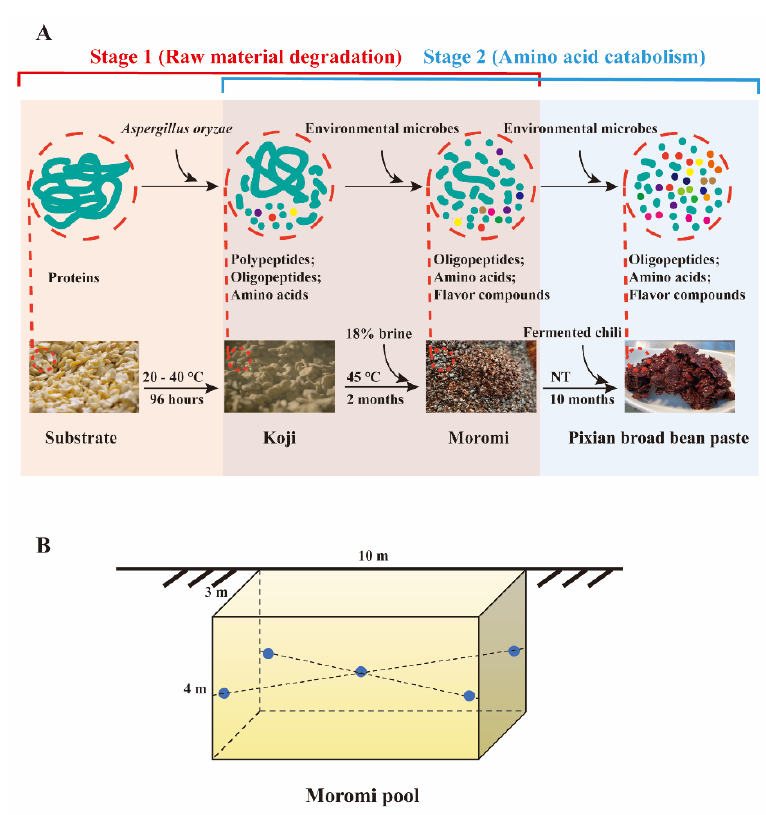
Figure 1. The production of Pixian broad bean paste, including ( A ) the production process and ( B ) the fermentative pool. Protein, as the raw material, can be biodegraded into polypeptides, oligopeptides and amino acids (regarded as microbial function-stage I in this study). Amino acids can then be catabolized into small molecular flavor metabolites (regarded as microbial function-stage II in this study). NT: natural temperature; moromi sample: five points (1.5 m depth) were drawn and mixed.